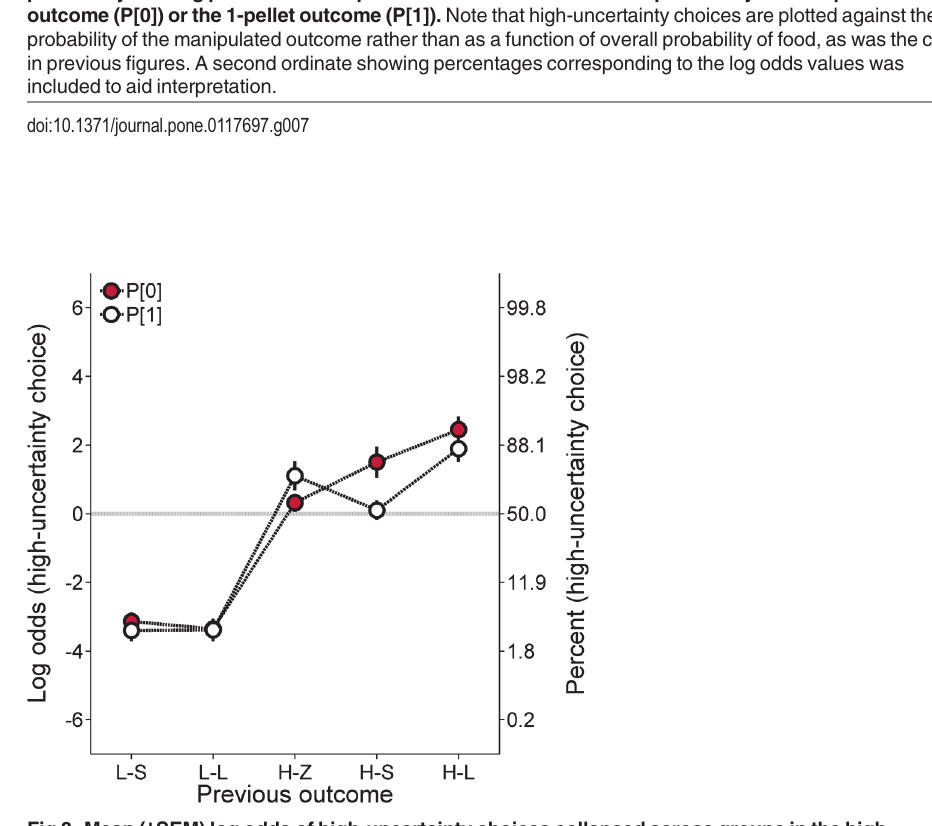
Fig 8. Mean ( ± SEM) log odds of high-uncertainty choices collapsed across groups in the high- uncertainty probability training procedure of Experiment 3A as a function of the outcome of the previous choice, collapsed across probability. A second ordinate showing percentages corresponding to the log odds values was included to aid interpretation. L-S = low-uncertainty-small; L-L = low-uncertainty- large; H-Z = high-uncertainty-zero; H-S = high-uncertainty-small; H-L = high-uncertainty-large; P[0] = probability of 0 pellets; p[1] = probability of 1 pellet.